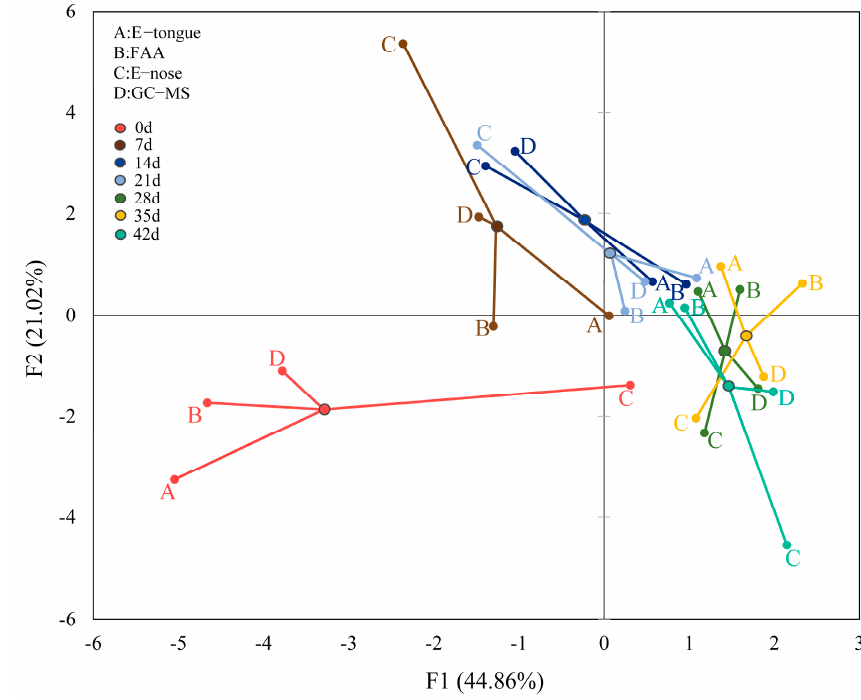
Figure 4. Schematic diagram of projected points of observed values. Table 3. RV coefficients of E-nose, E-tongue, FAA, and